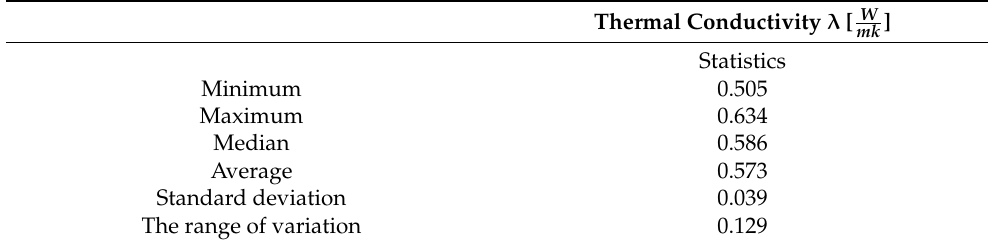
Table 7. Average thermal conductivity for basalt dust A for all samples for water − mix ratio = 0.7.